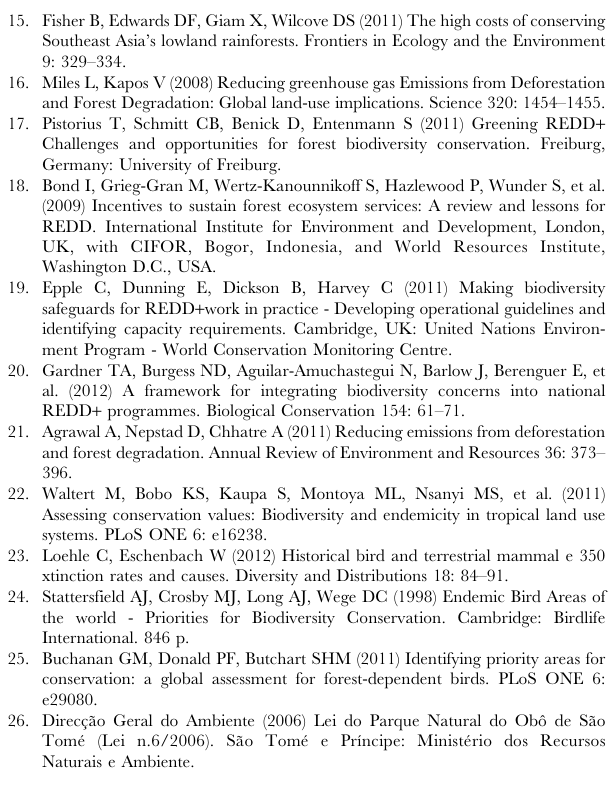
Figure S1 Aboveground carbon stocks across land-uses. (DOCX) Figure S2 Sample-based rarefaction curves for birds (a,b) and trees (c,d) across land-uses. (DOCX) Table S1 Avoided deforestation according to two sce- narios simulated in OSIRIS. Table S2 Sa˜o Tome´ and Prı´ncipe’s nationally endemic forest-dependent